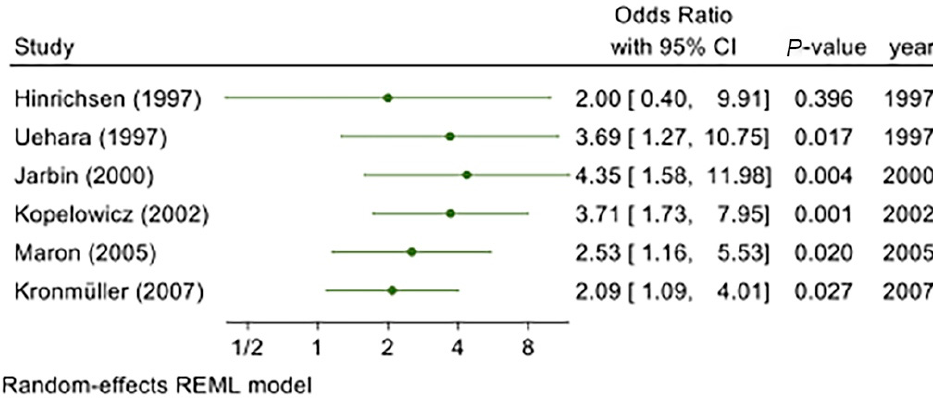
Figure 4. Forest plot of the cumulative meta-analysis [35,37–41].